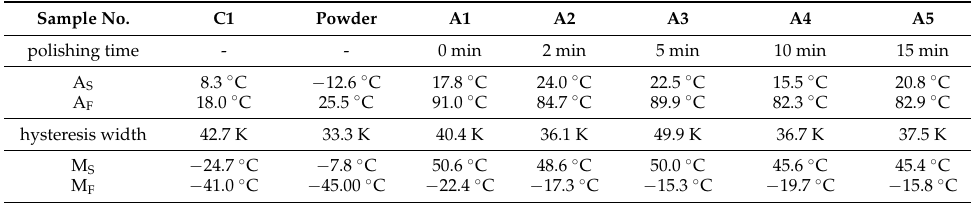
Table 4. DSC measurement results for tested samples.